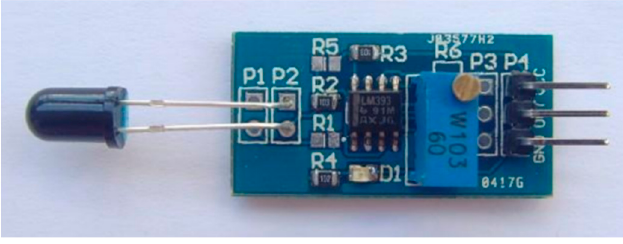
Figure 4. Flame sensor used in the proposed system.